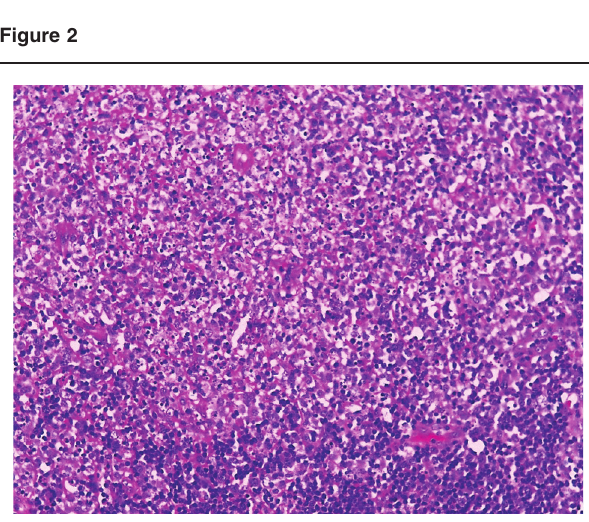
Histopathological image of lymph node.